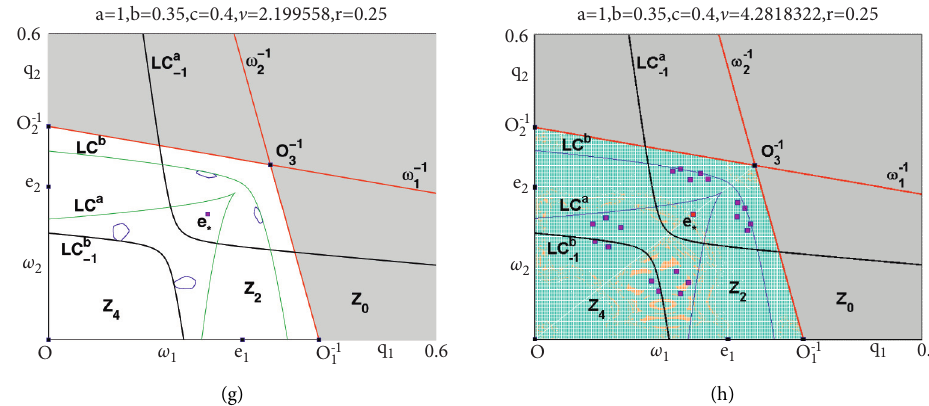
Figure 4: At a � 1 , b � 0 . 35 ,c � 0 . 4 ,c � 0 . 3 , r � 0 . 7 ,r � 0 . 5, the basin of attraction for (a) period-8 cycle, ] � 3 . 3285 ,v � 3 . 852. 1 2 1 2 1 2 � 4 . 03 ,v � 3 . 852. (c) One-piece chaotic attractor, ] � 4 . 4675 ,v � 3 . 852. (d) One-piece chaotic (b) Two-piece chaotic attractor, ] 1 2 1 2 � 4 . 647 ,v � 3 . 852. (e) One-piece chaotic attractor, ] � 4 . 63 ,v � 3 . 3 . 95. At a � 1 ,b � 0 . 35 , c � 0 . 4 ,r � 0 . 25, the basin of attractor, ] 1 2 1 2 attraction for (f) period-4 cycle, ] � 4 . 1772185. (g) Four closed rings, ] � 4 . 2199558. (h) Period-20 cycle, ] � 4 .